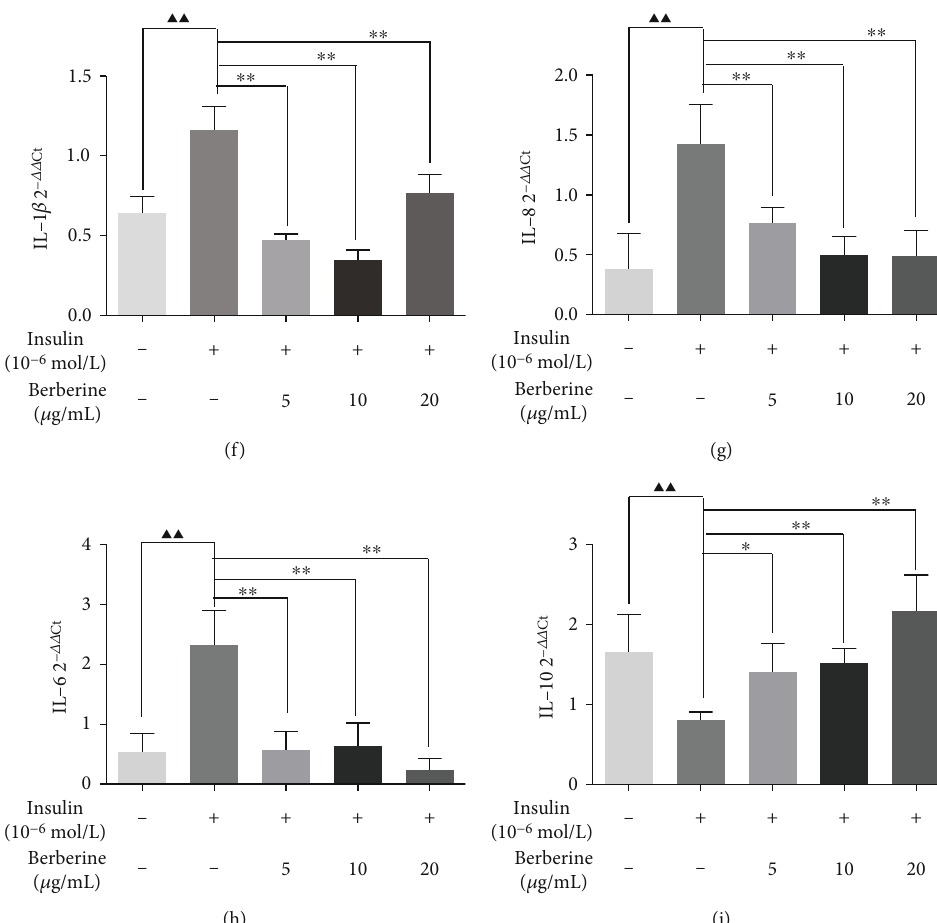
Figure 5: E ff ect of BBR on glucose consumption, uptake, and in fl ammatory factors in HepG2-IR cells. (a) Glucose consumption from the culture medium after 24h treatment. (b) Cell viability of HepG2 cells. (c) Uptake of 2-NBDG into HepG2-IR cells. (d) The quantitative analysis of fl uorescence from eight independent replicates. (e – i) The expression of TNF- α , IL-1 β , IL-6, IL-8, and IL-10 in HepG2-IR cells was measured by qPCR. ▲ P < 0 : 05 and ▲▲ P < 0 : 01 , Con vs. model; ∗ P < 0 : 05 and ∗∗ P < 0 : 01 , model vs. BBR-treated